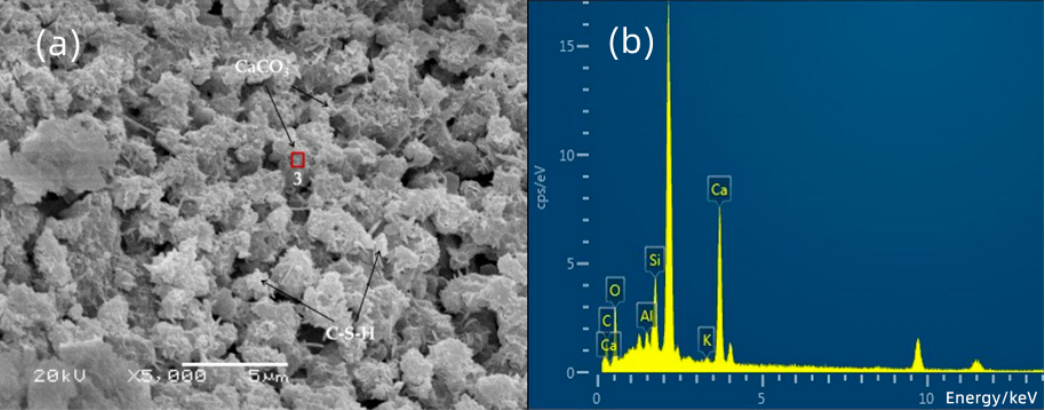
Figure 9. The micromorphology and EDS results of the hydraulic lime K3 fractured samples at 28 days: ( a ) SEM image of K3 mortar curing 28 days; ( b ) EDS result. Table 3. The EDS data of red areas in SEM images. Area Element, Atomic (%)